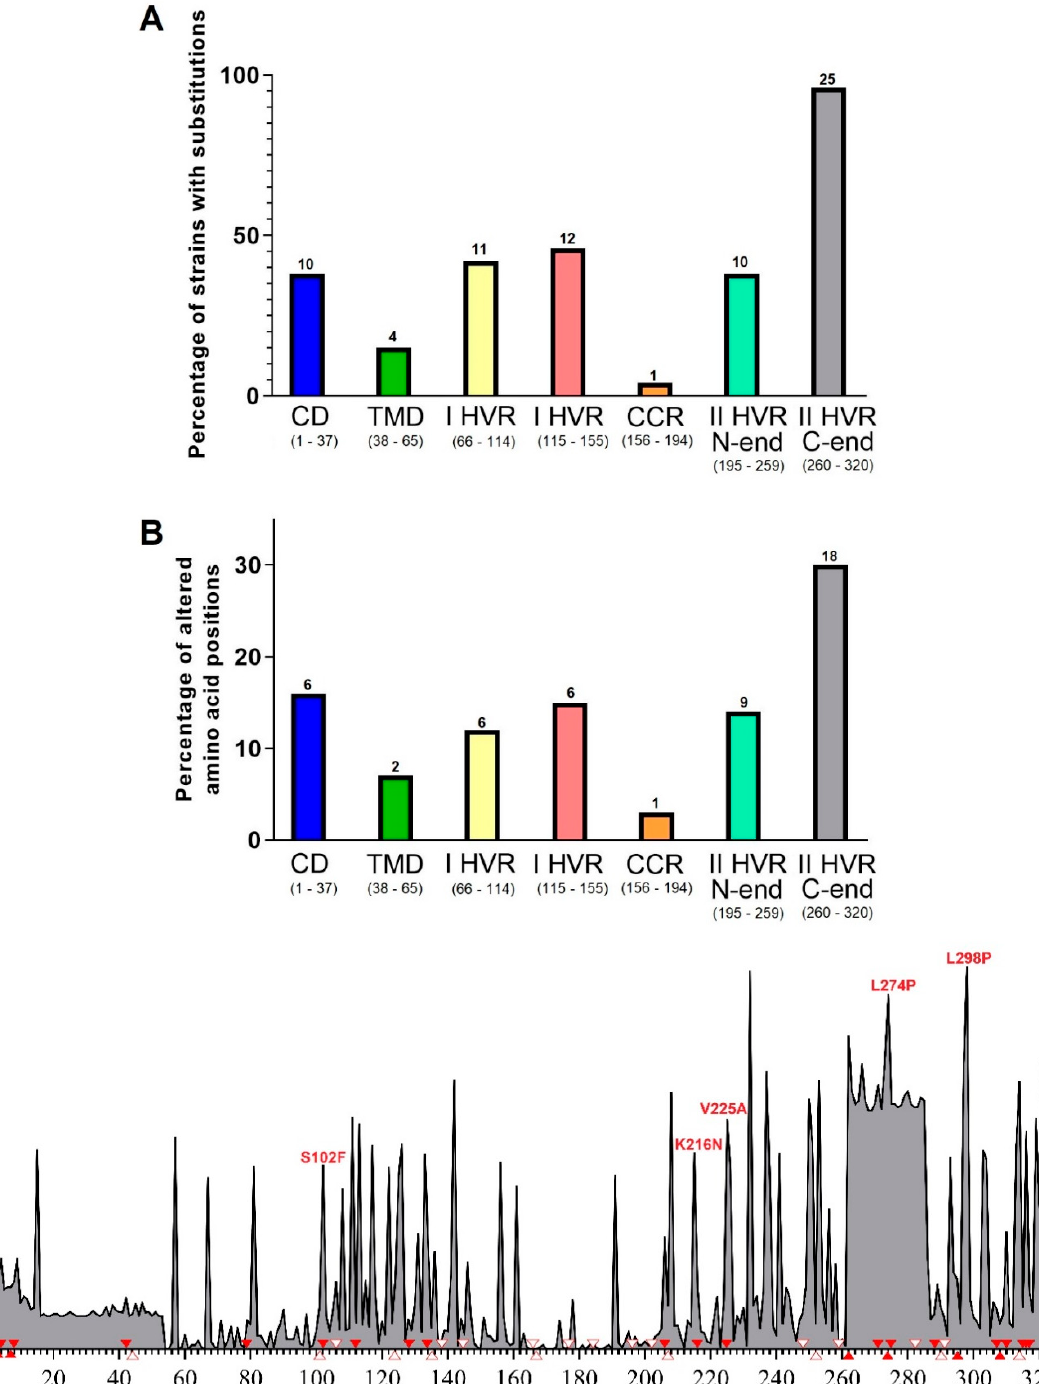
Figure 2. Variability of G protein structural regions compared with the reference strain. Comparison uses St. Petersburg RSV-A isolates (n = 27) from the 2013–2014 epidemic season. The rate of strains ( A ) and position frequencies ( B ) with aa substitutions identified in specific G protein structural domains. In brackets, in the signature to the X-axis, the numbering and quantity (n) of the amino acid residues of the regions are indicated. Above the diagrams, the number of divergent strains ( A ) or amino acid positions ( B ) is indicated. The positions of the amino acid substitutions are shown with red triangles (filled and empty for non-unique and unique mutations, respectively) at the Shannon entropy plot ( С ) (based on 1491 sequences available in the GenBank database). CD—central domain, TMD—transmembrane domain, I HVR—I hypervariable region, II HVR—II hypervariable region.